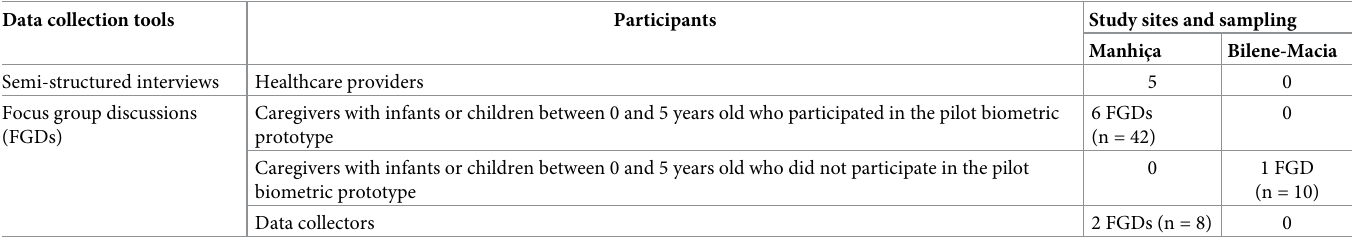
Table 1. Data collection tools and sample